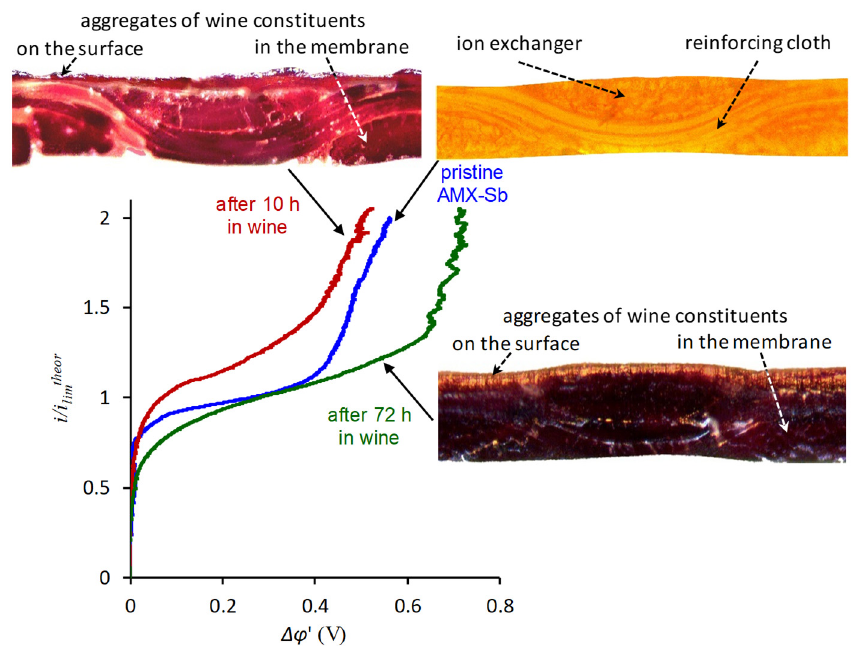
Figure 7. Corrected current–voltage characteristics after ohmic component subtraction, obtained in 0.02 NaCl solution for pristine and fouled in red wine AMX-Sb membrane samples. The insets show optical images of cross-sections of these samples. The value of i lim theor was calculated using the L é v ê que equation [163]. Adapted from